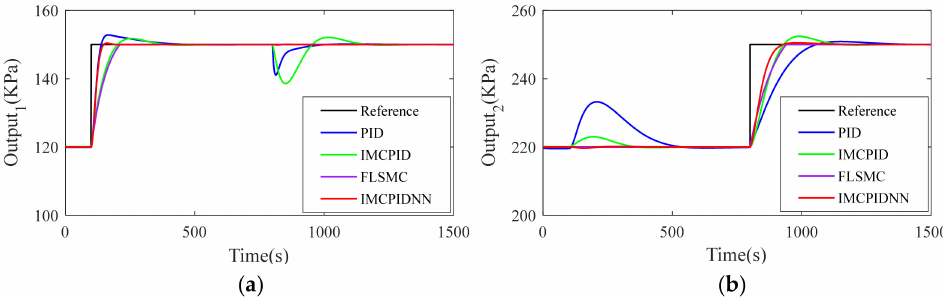
Figure 9. Comparison of sequential step responses with +20% variation on time constant and gains: